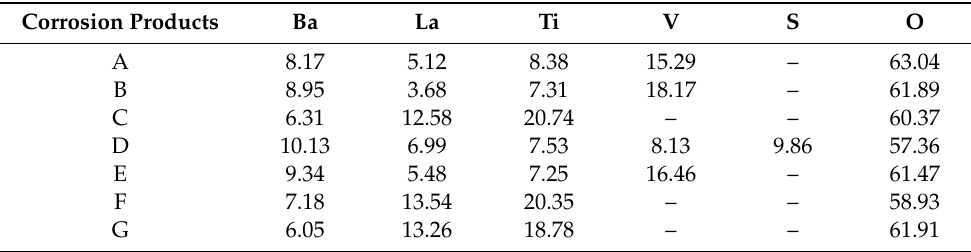
Figure 3. Cross-sectional images of BaLa 2 Ti 3 O 10 ceramic after hot corrosion in V 2 O 5 salt at 900 °C for 4 h. ( a – c ) show the images with different magnifications. Table 2. Compositions of compounds A–G in Figures 3 and 4 (in at.%).